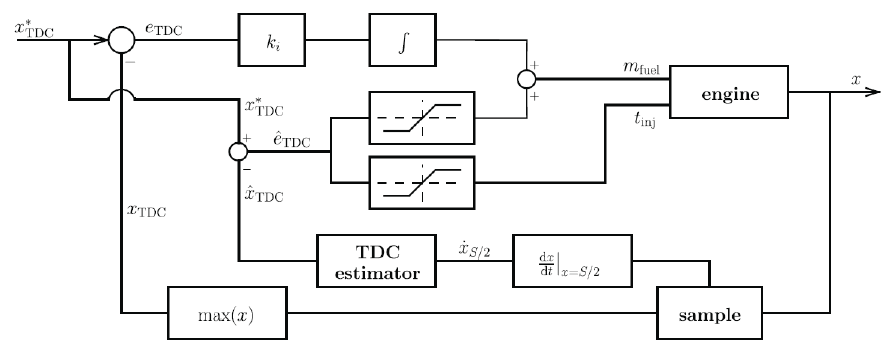
Figure 22. Free-piston engine estimation and control system at Newcastle University [44].